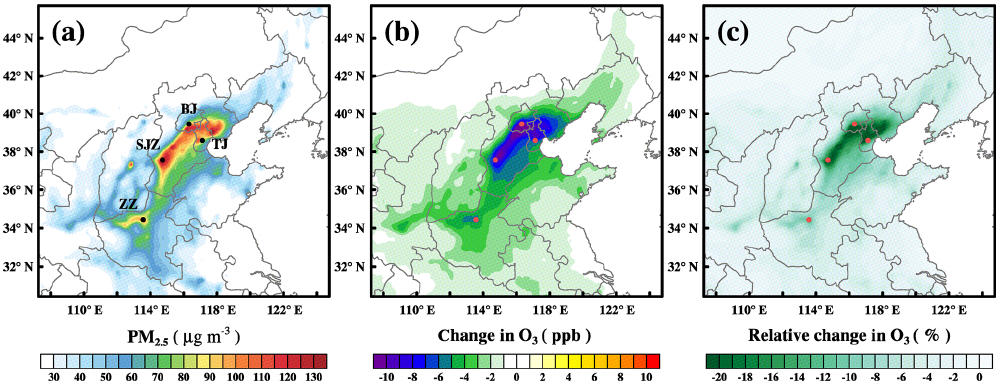
Figure 4. Mean distributions of PM 2 . 5 (a) , change in O 3 (b) and relative change in O 3 (c) at the surface over CEC during high PM 2 . 5 episodes. Dots denote the four typical cities in CEC; BJ = Beijing; TJ = Tianjin; SJZ = Shijiahuang; ZZ = Zhengzhou.